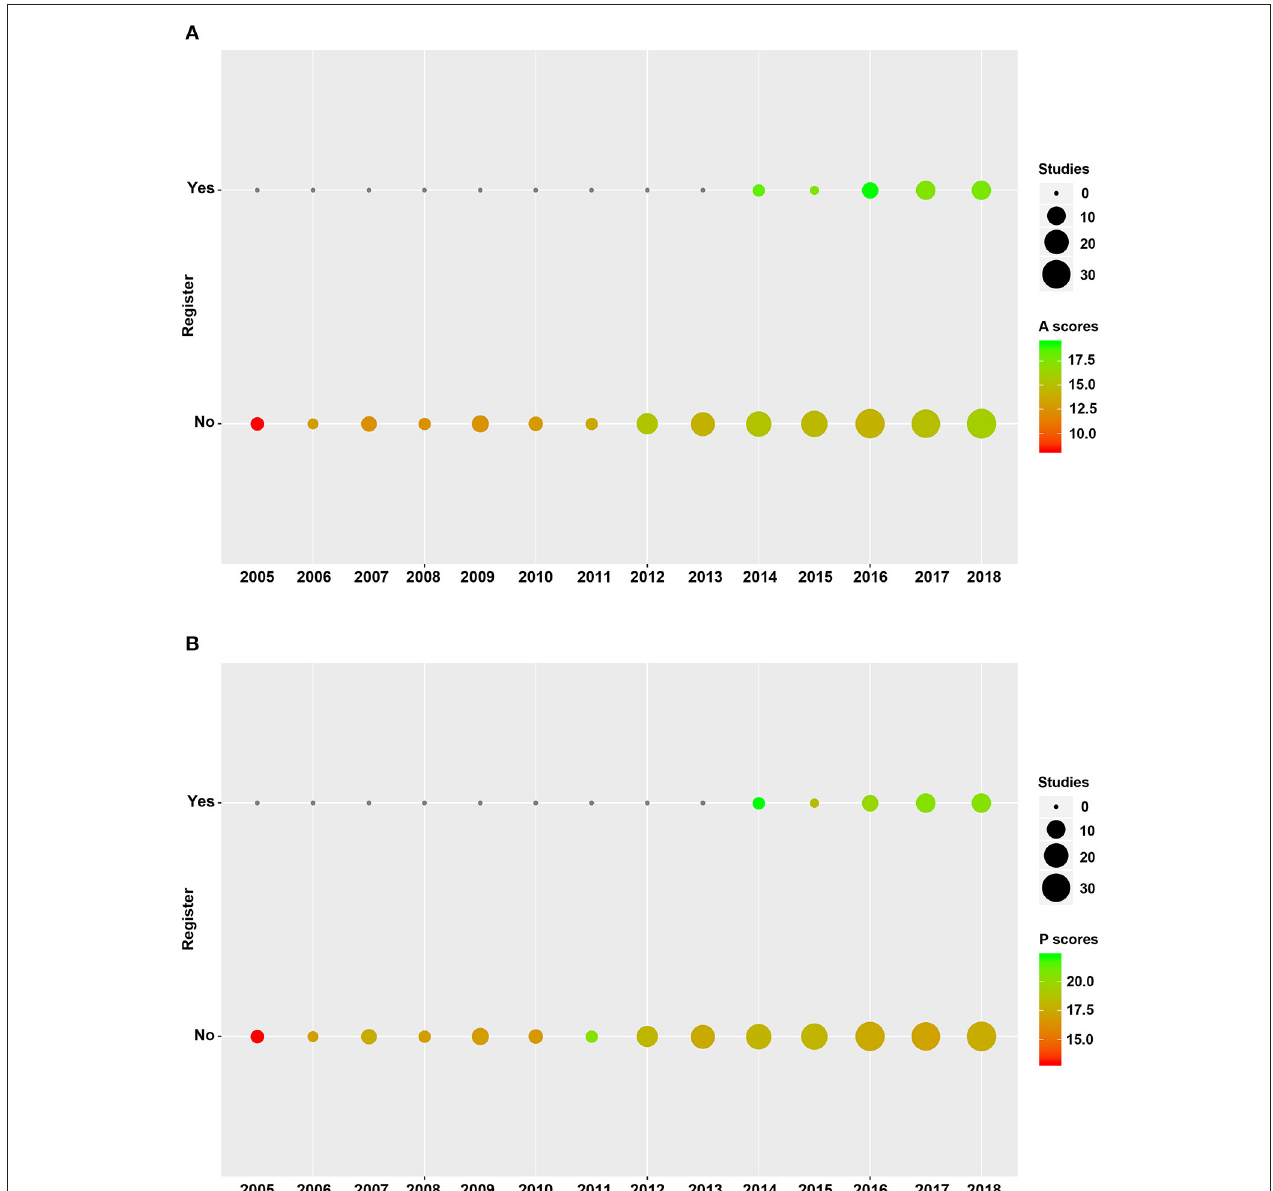
FIGURE 3 | Quality of registered and non-registered systematic reviews included in the study. (A) Methodological quality of registered and non-registered systematic reviews. (B) Reporting quality between registered and non-registered systematic reviews. A, Assessment of Multiple Systematic Review 2; P, Preferred Reporting Items for Systematic Reviews and